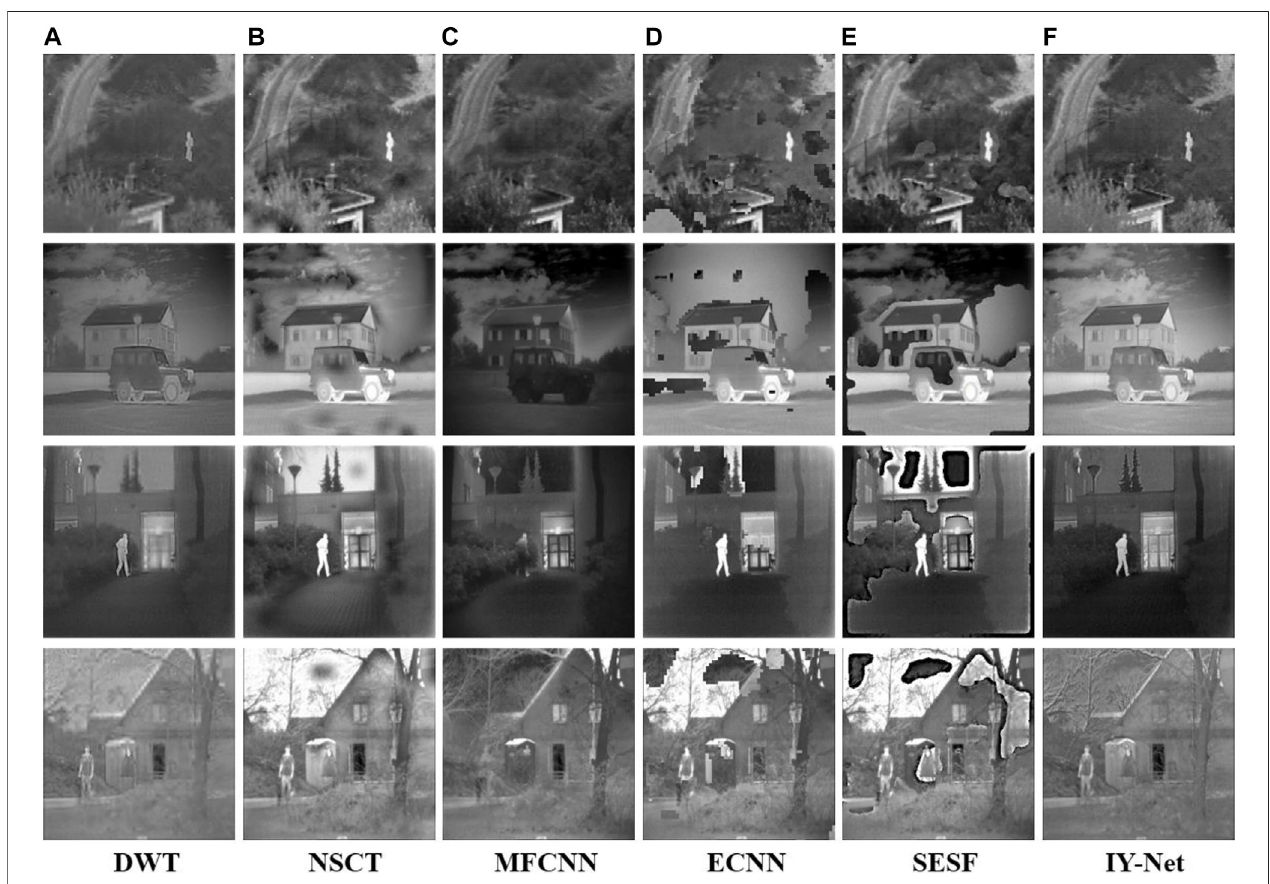
FIGURE 6 | Experiment on 4 pairs of infrared and visible images. (A) DWT, (B) NSCT, (C) MFCNN, (D) ECNN, (E) SESF, (F) IY-Net.